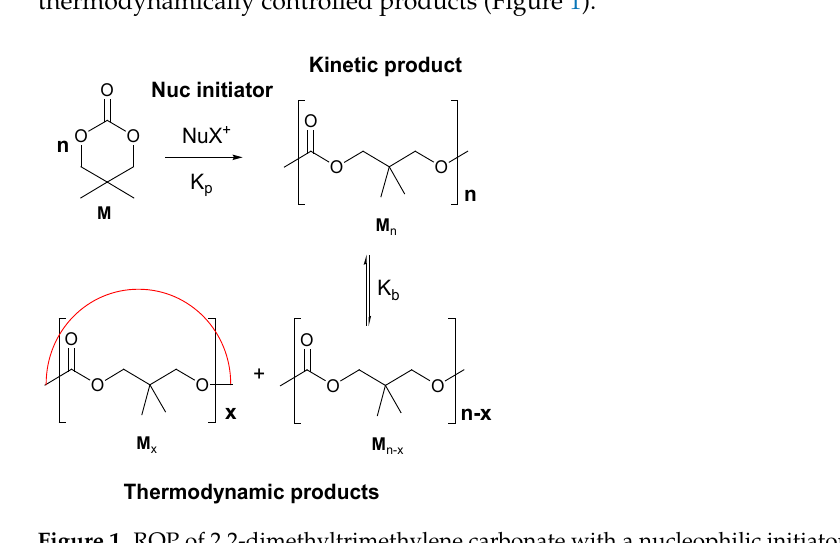
Figure 1. ROP of 2,2‐dimethyltrimethylene carbonate with a nucleophilic initiator [20]. In a spontaneous ROP, the Gibbs free energy must be negative (Δ Gp < 0), i.e.,